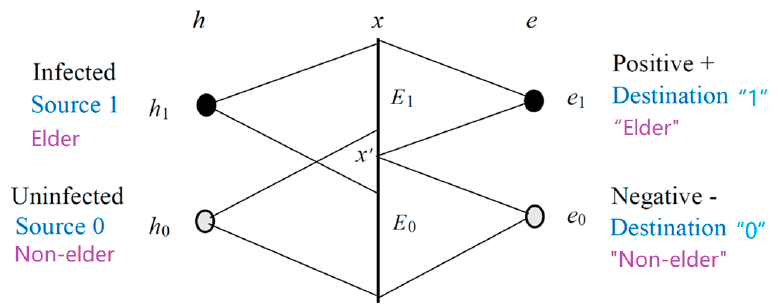
Figure 6. Illustrating the medical test and the binary classification for explaining confirmation. If x is in E 1 , we use e 1 as prediction “ h is h 1 ”; if x is in E 0 , we use e 0 as prediction “ h = h 0